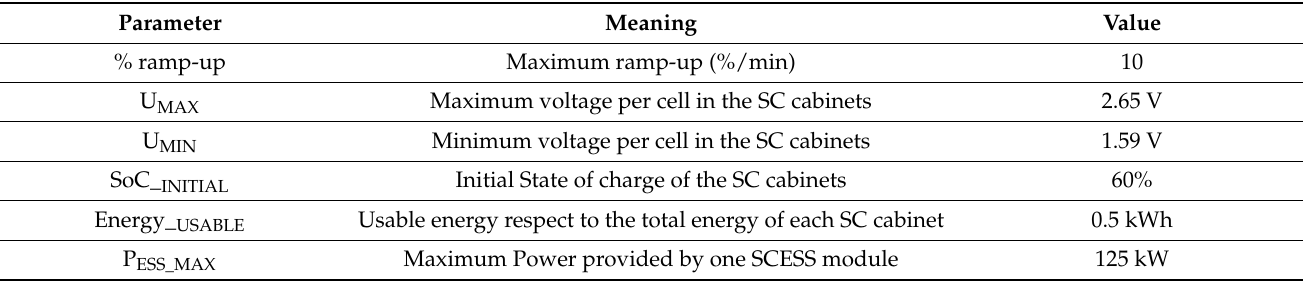
Table 1. Main input parameters of the simulation model.